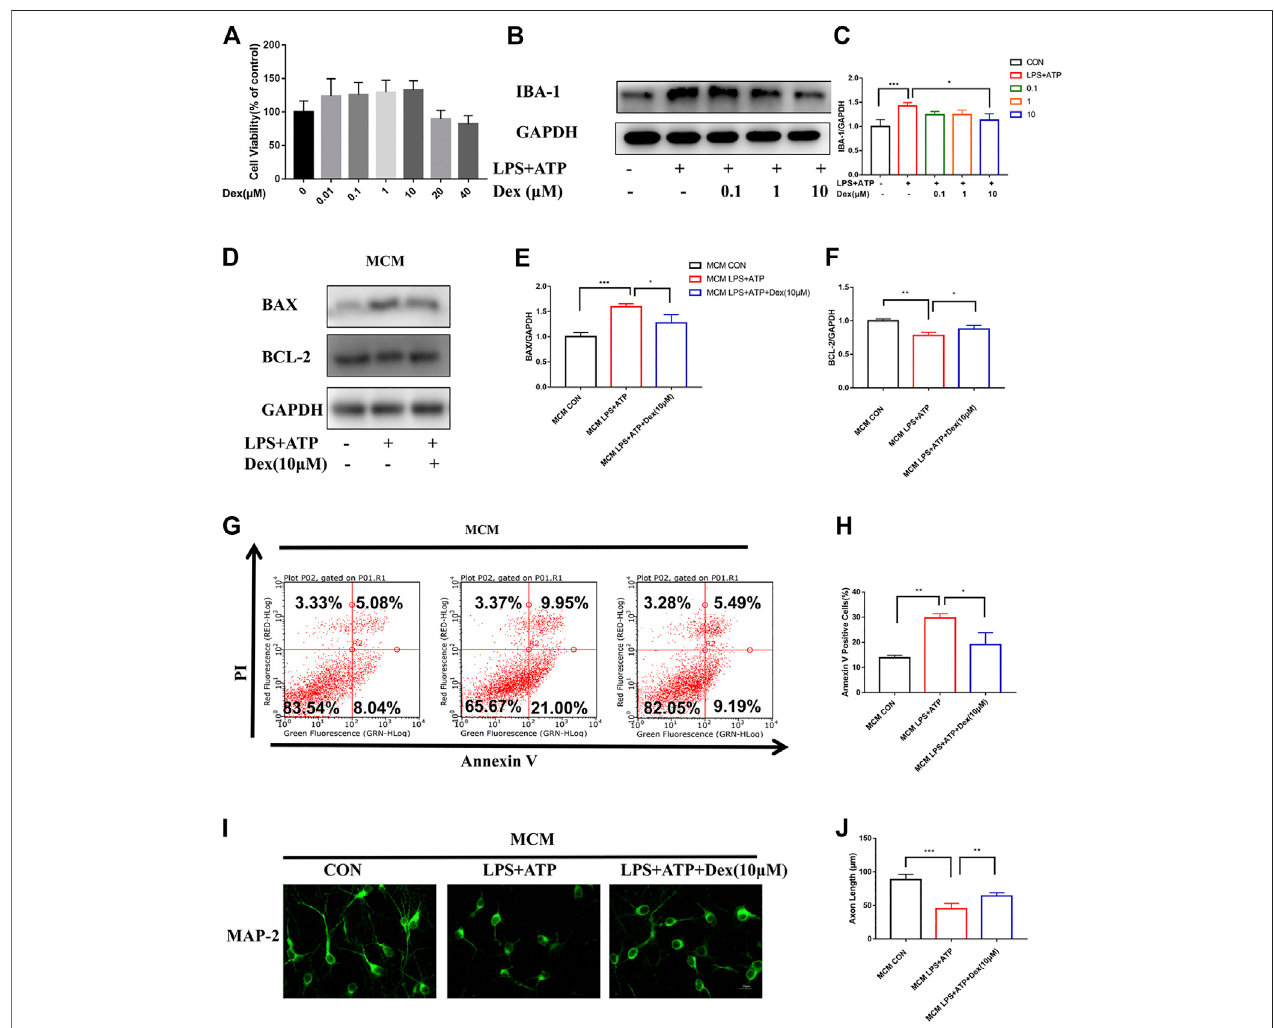
FIGURE 3 | DEX reduced microglia activation and attenuated neuronal cell apoptosis in vitro . DEX reduces microglia activation and attenuates neuronal cell apoptosis in vitro . The primary microglia viability and toxicity test were examined by the CCK-8 kit. Each group had three replicates, and the test was repeated 4 times independently (A) . LPS-primed (100 ng/ml) primary microglia were treated with different doses of DEX for 5 h and then stimulated with ATP (5 mM) for 30 min. The expressionofIBA-1detectedbyImmunoblotting (B) andthestatisticaldatashownin (C) (means ± SEM, n (cid:1) 4).LPS-primedprimarymicroglialcellswereincubated with DEX for 5 h, then stimulated with ATP for 30 min.Microglia conditioned medium including without any treatment, treated with LPS (100 ng/ml, 5 h)plus ATP(5 mM, 30 min), and DEX (10 μ M, 5 h) protected, MCM mixed with 2% B-27 Neurobasal medium (1:1) and incubated the cells for 24 h, primary neuronal cells were incubated with mix MCM separately, collected for Immunoblotting, immuno fl uorescence staining and cell fl ow analysis. Expression of apoptosis-related proteins BAX and Bcl-2 detected by Immunoblotting (D) , the statistical data are shown in (E,F) (means ± SEM, n (cid:1) 4). Apoptosis indicators were detected using a cell fl ow cytometer (G) . Data analysis is shown in (H) (means ± SEM,n (cid:1) 4). MAP-2 expression was stained by immuno fl uorescence and axon length was calculated by IMageJ software (I) , data analysis in (J) (means ± SEM, n (cid:1) 4). All the above data analysis were presented as the means ± SEM,* p < 0.05, ** p < 0.01, *** p < 0.001 compared with the corresponding group by Student ’ s t